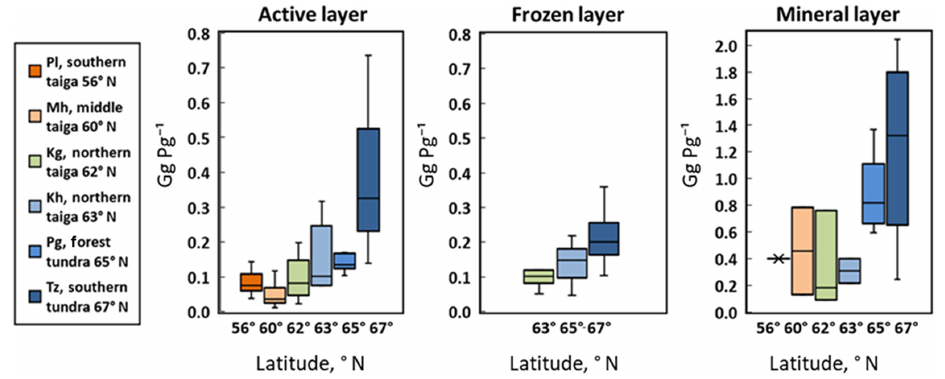
Figure 4. The ratio Hg:C (Gg Pg − 1 ; median ± IQR) in the active layer, frozen peat, and mineral horizons across the WSL latitudinal transect.